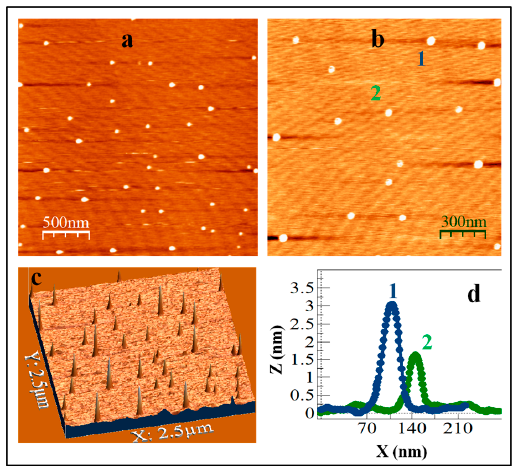
Figure 2. Atomic force microscopy (AFM) topography images of aluminum nitride